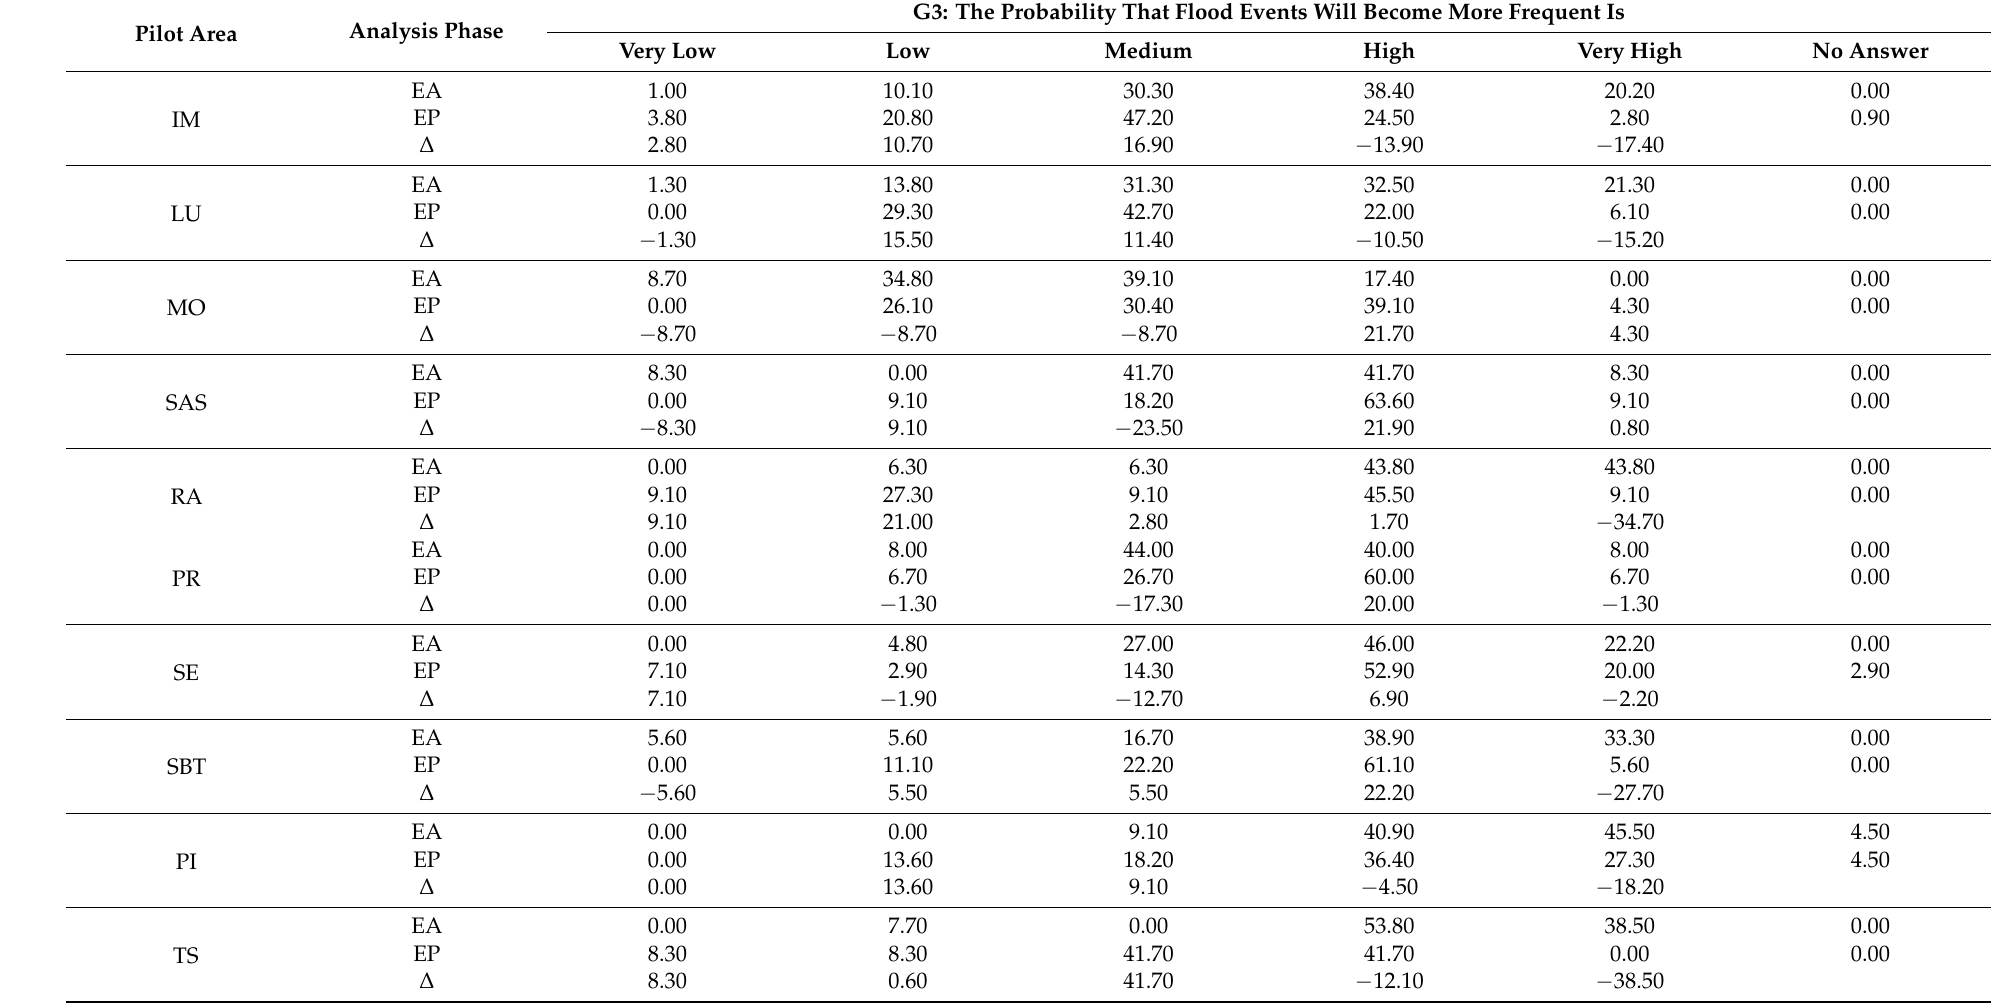
Table A4. Answers to the question G3 in percentages per each pilot area, in the ex-ante (EA) and in the ex-post (EP) phases, and their variation ( ∆